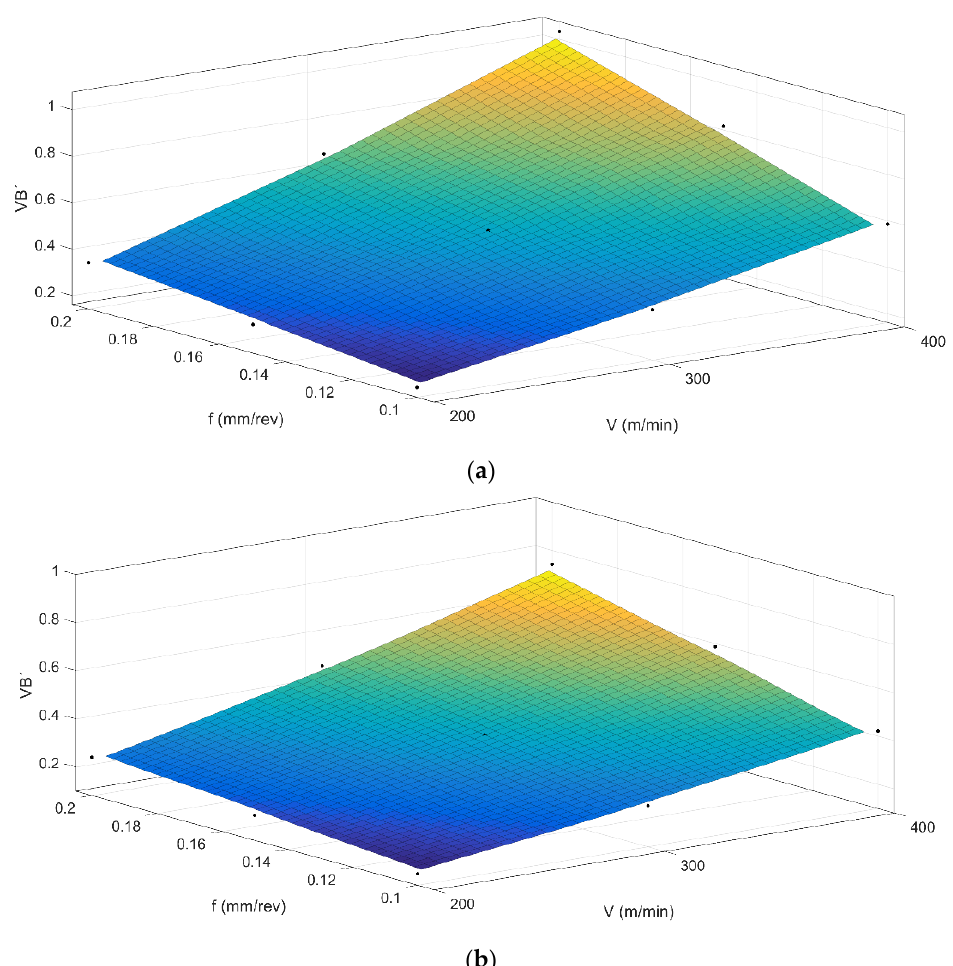
Figure 4. Behavior of the initial wear progression for ( a ) MQL (Minimum Quantity Lubrication) machining and ( b ) dry machining.